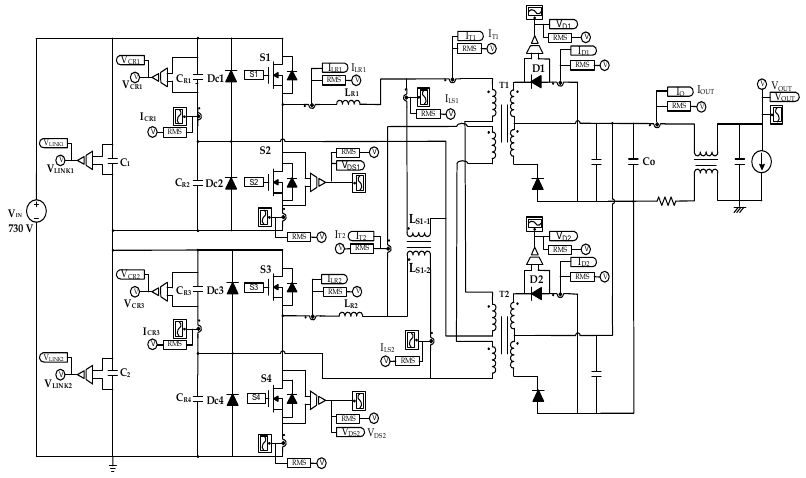
Figure 14. Simulation circuit of the proposed converter.